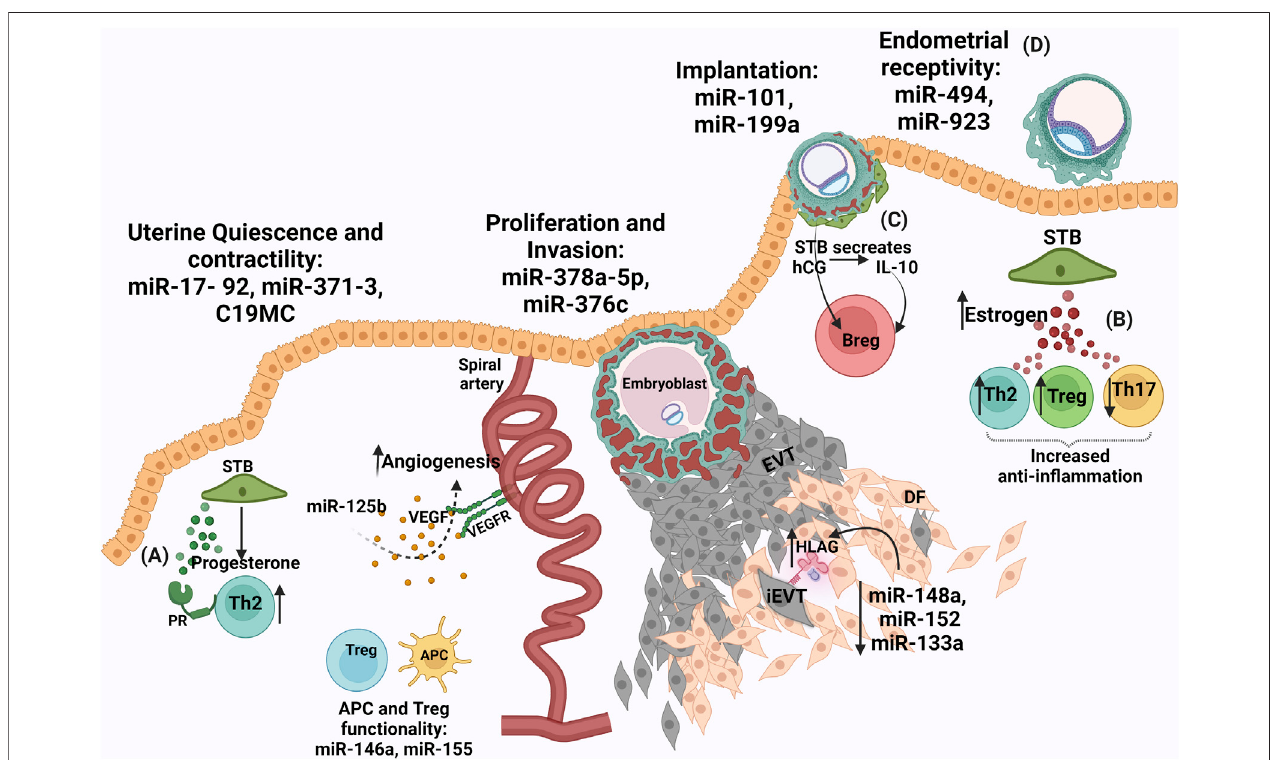
FIGURE1| Conjunctionofbiomoleculesinhealthypregnancy (A) Progesteronefromsyncytiotrophoblasts(STB)causesTregexpansiontoformatolerogeniczone (B) Increased estrogen levels from STB aids an anti-in fl ammatory response (C) Human chorionic gonadotrophin hormone (hCG) released from STB induces interleukin- 10 (IL-10) which causes expansion of regulatory B cells and an assured immune environment (D) miRNAs are involved during placentation for endometrial receptivity: miR-30 family, miR-494, miR-923, implantation: miR-101 and miR-199a, proliferation and invasion: miR-378a-5p and miR-376c, uterine quiescence and contractility: miR-17- 92, miR-371 – 3, C19MC, APC and Treg functionality. miR0146a and miR-155 are involved in both pro- and anti-angiogenic functions. Reduced expression ofmiR-148a, miR-152,miR-133aintheextravilloustrophoblasts(EVTs)ensureshighlevelsofHLA-GtoaidinaconduciveenvironmentbyregulatingNKcell